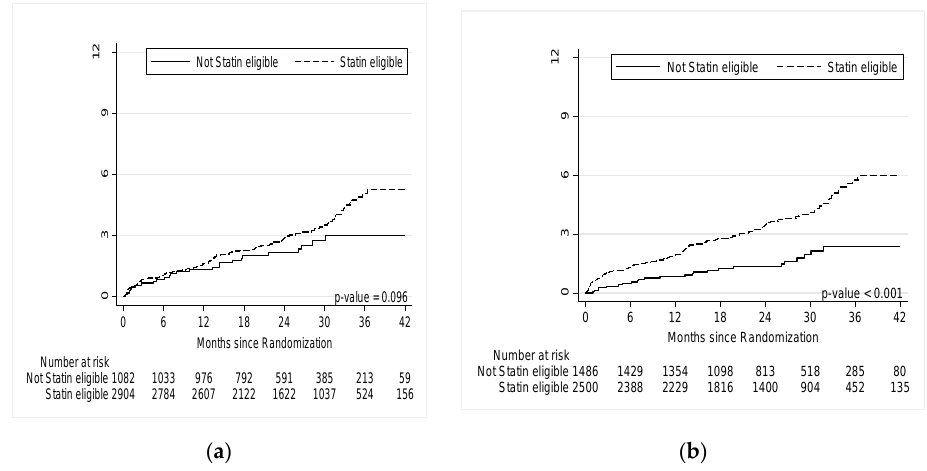
Figure 2. Kaplan–Meier curves for primary endpoints (all-cause death/MI/UA) in statin eligible vs. not eligible: ( a ) according to current 2018 Guidelines including CAC; and ( b ) using the modified 2018 Guidelines including CAC and modified CAD score.